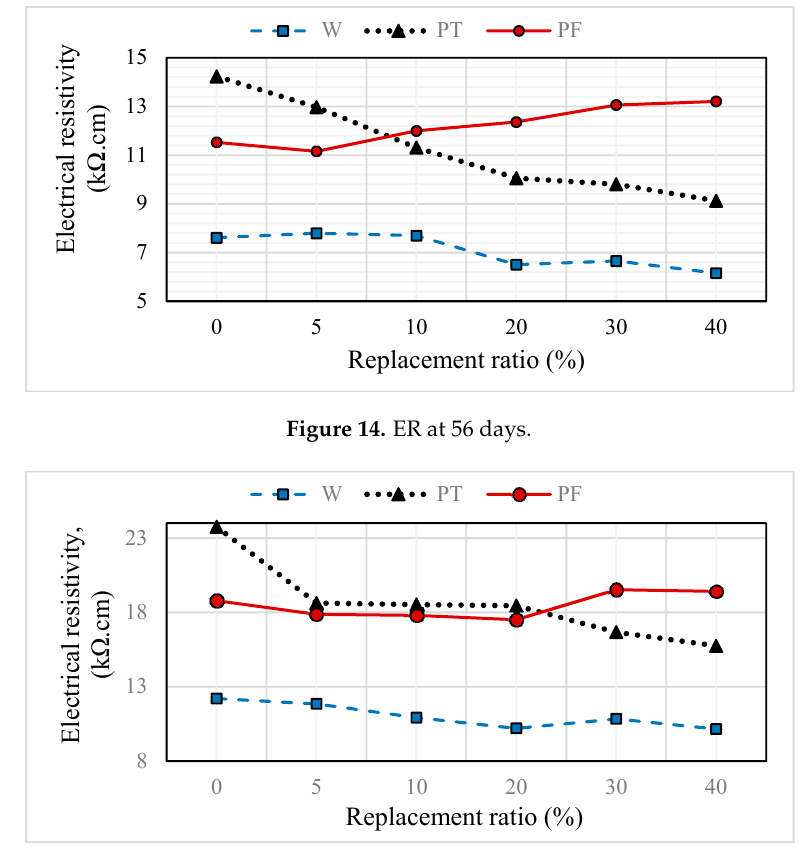
Figure 15. ER at 180 days.